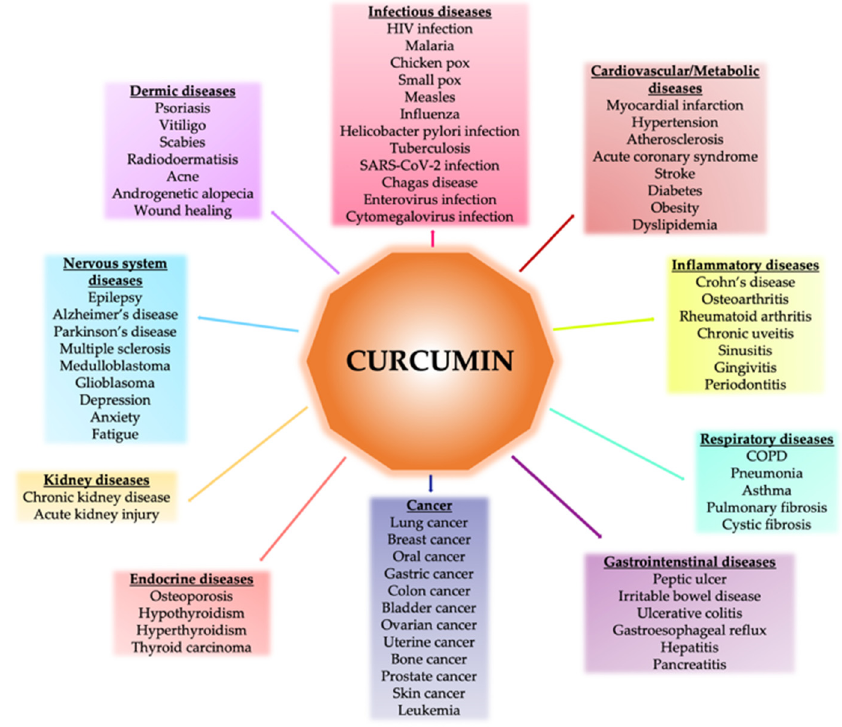
Figure 2. Effects of curcumin in different diseases.